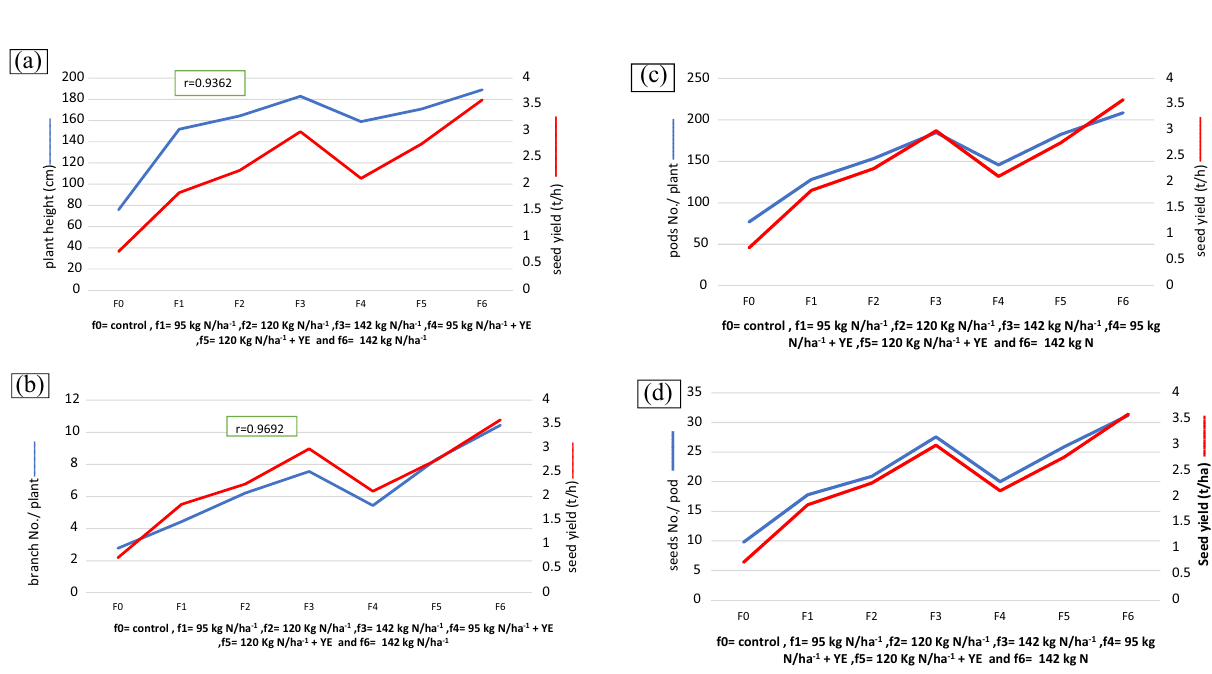
Figure 1. Correlation of Canola seed yield (t/h) and chlorophyll a/b ratio as affected by different nitrogen rates without and with yeast extract.